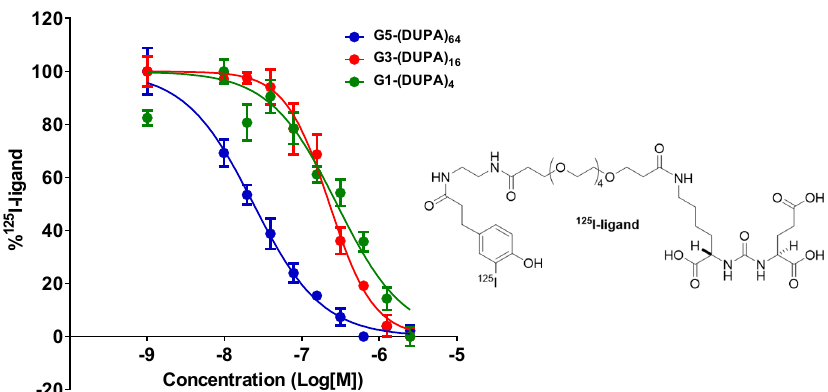
Figure 3. The PSMA binding affinities of G1-(DUPA) 4 , G3-(DUPA) 16 , and G5-(DUPA) 64 were evaluated using PC3-PIP cells and a 125 I-labeled PSMA radioligand as the PSMA-specific competitor. The IC 50 values of G1-(DUPA) 4 , G3-(DUPA) 16 , and G5-(DUPA) 64 were calculated to be 23.6 nM ( R 2 = 0.95), 226.7 nM ( R 2 = 0.94), and 282.3 nM ( R 2 = 0.88), respectively ( n = 4).